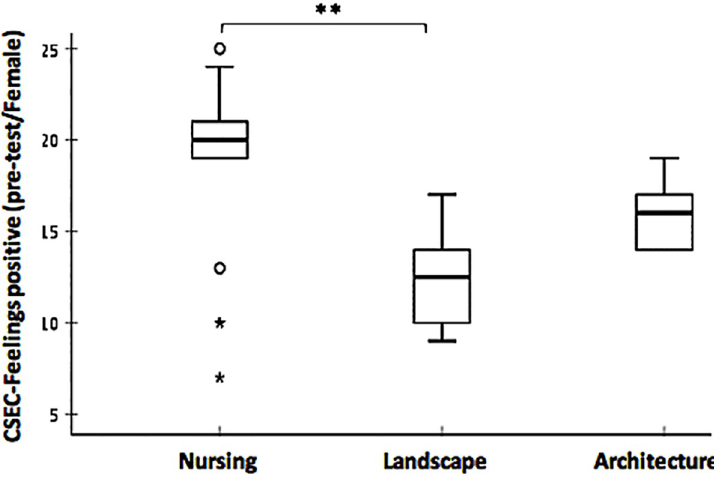
Fig 1. Comparison of CSES-Feelings median scores for positively worded items across the three study groups in the pre-test female group. The boxplots demonstrate comparison of CSES-Feelings median scores for positively worded items across the three study groups in pre-test (Nursing = 20, Landscape = 12.5, Architecture = 16) female group. The boxes are bound by the interquartile range (IQR) (top of the box represents the 75 th percentile, while the bottom of the box represents the 25th percentile). The boxes are divided by the median, and the whiskers attached to the box represent the minimum and maximum scores. Pairwise comparison demonstrated statistically significant differences in the CSES Empathy scores across different study groups (Kruskal-Wallis Rank Sum test, �� p < 0.01; 2-tailed). Extreme values and outliers lied beyond the whiskers and denoted differently with a star and a circle